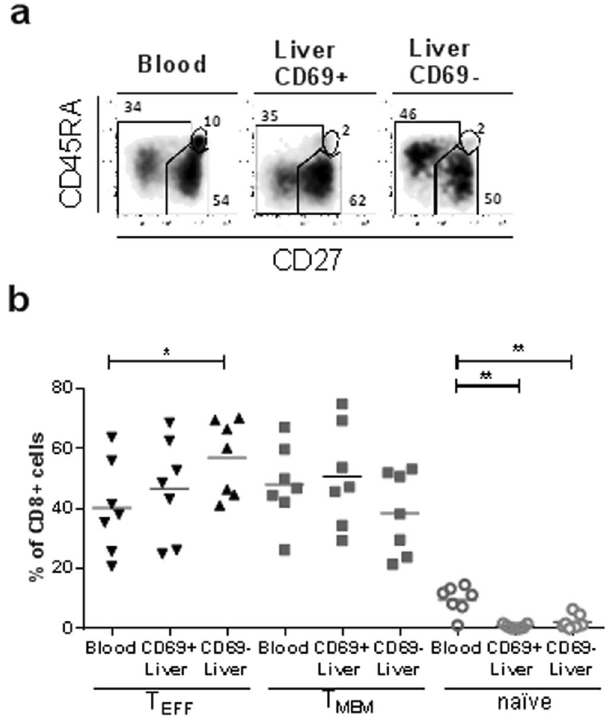
Figure 3. ( a ) Representative flow cytometry plots showing CD27 and CD45RA expression with gates indicating effector memory (T EFF , CD45RA ± CD27 − ), memory (T MEM , CD45RA-CD27 + ) and naïve (CD45RA + CD27 + ) CD8 + T cells in control blood and liver (CD69 + and CD69 − ). ( b ) Frequency of T EFF , T MEM and naïve CD8 + T cells as a percentage of total CD8 + T lymphocytes in control blood and liver (CD69 + and CD69 − ). Bars indicate mean. Statistical analyses; paired t-test * p < 0.05, ** p < 0.01, **** p <